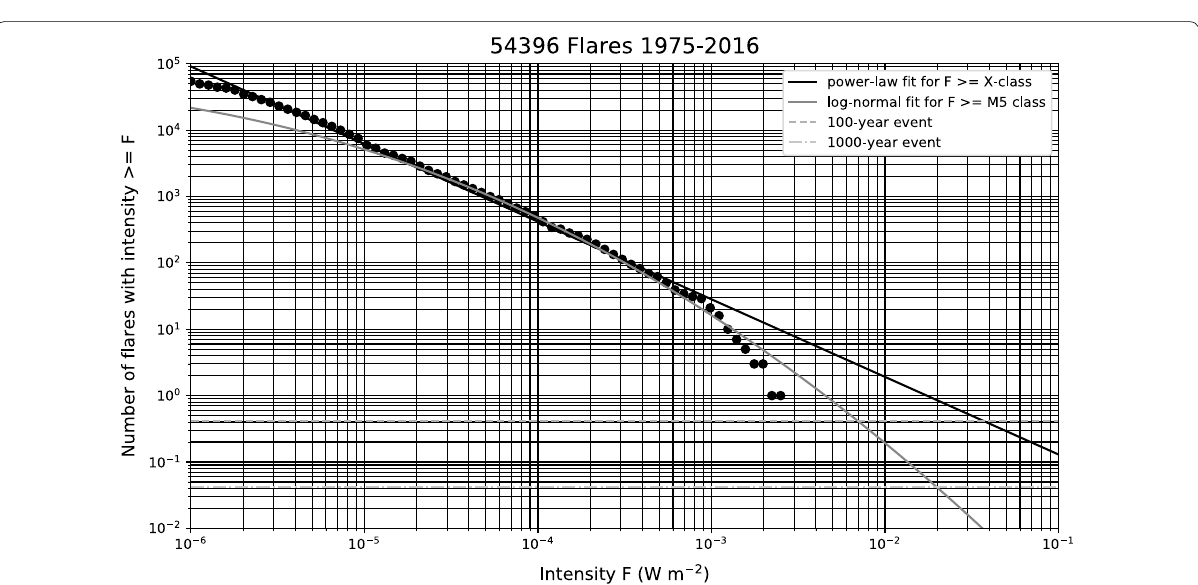
Fig. 6 Cumulative distribution function of solar flares for time interval 1975 to 2016. The data points are displayed at even intervals in logarithmic scale. Log-normal and power-law fits are shown by thick and thin solid curves, respectively. The best fitted parameters are α σ =